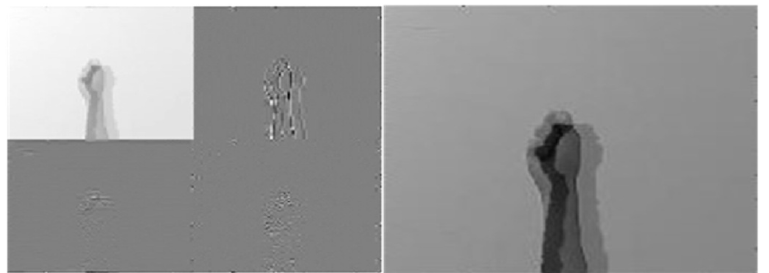
Figure 12. The “mean-mean” merge strategy performed on two 1st level DWT coefficients derived from CCD RGB-IR and depth-grayscale hand gesture images ( the left ) and the IDWT-decoded recovery image of the “mean-mean” merged ( the right ) for VGG-16 CNN deep learning.